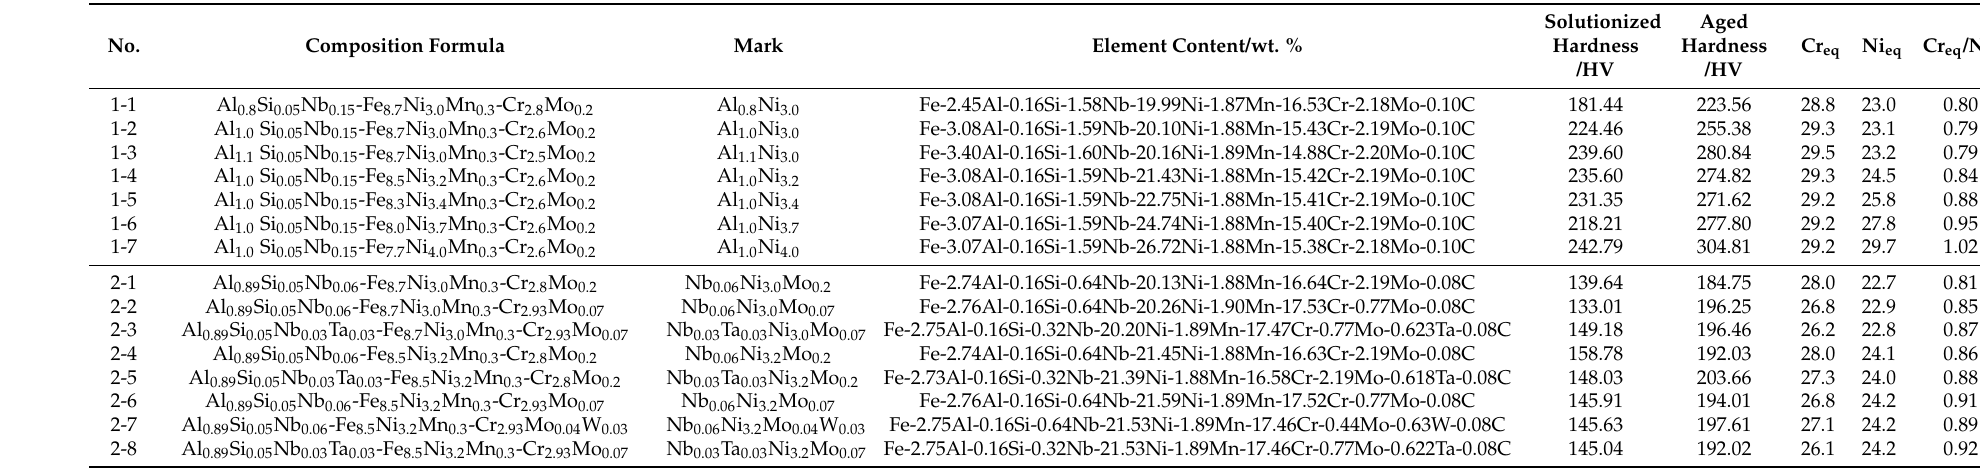
Table 2. The composition formula, mark, weight percentage, hardness (both solutionizing and aging states), Cr and Ni equivalents (calculated by Uggowitzer’s equivalent equations [28]) of designed